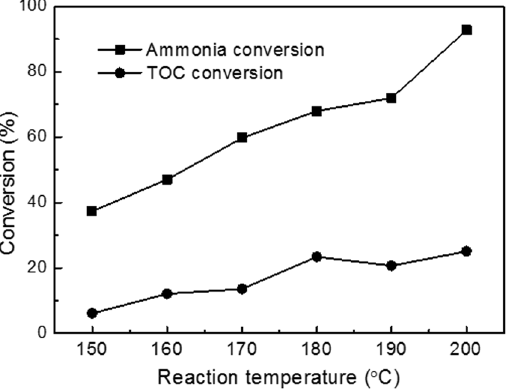
Figure 7. Effect of temperature on ammonia and TOC conversion of CH 3 COONH 4 solution over Ru-Cu/C catalyst. Conditions: